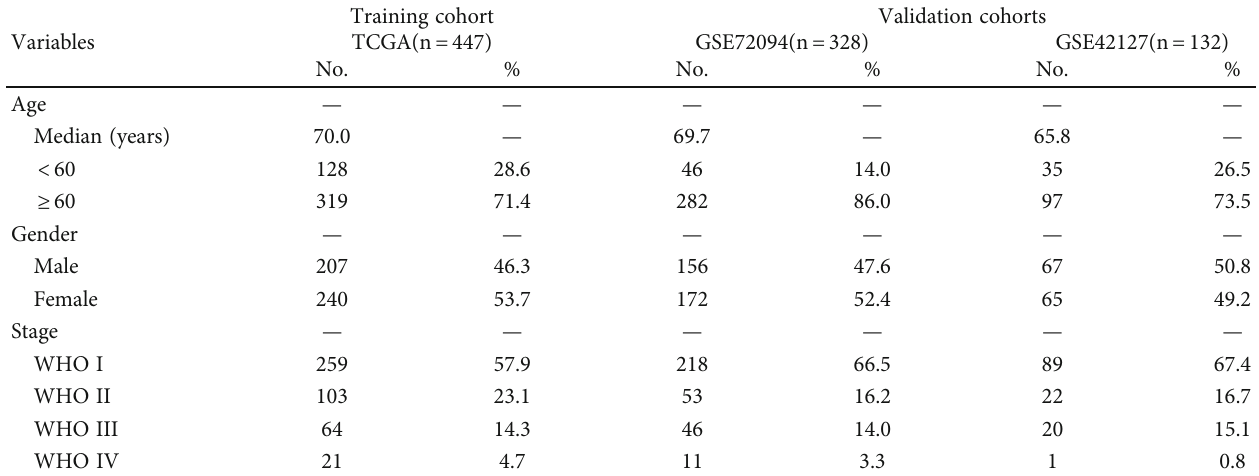
Table 1: Clinical characteristics of patients in the training cohort and validation